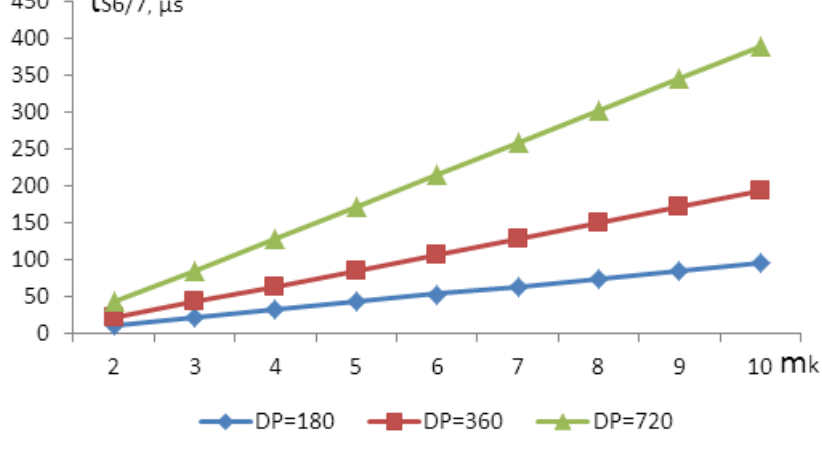
Figure 5. Time of the object